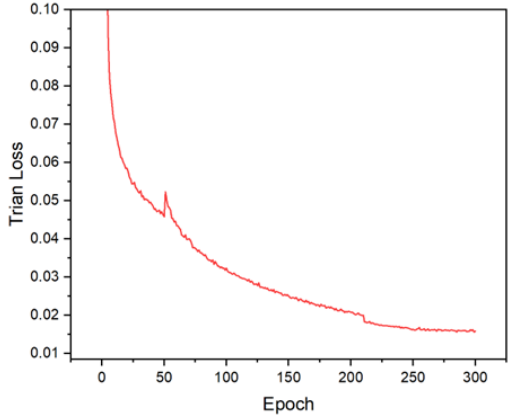
Figure 13. Training loss curve of VV-YOLO model.